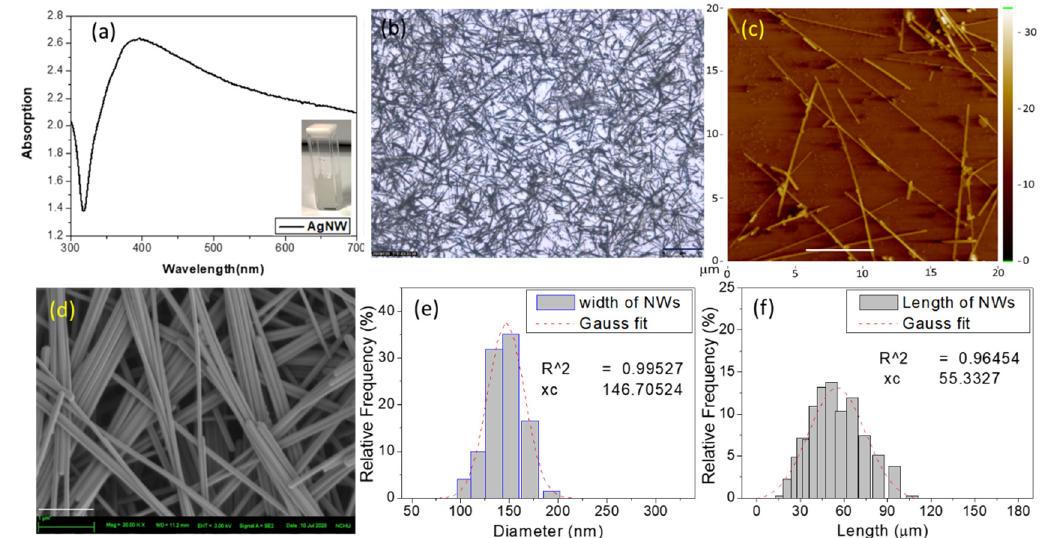
Figure 2. ( a ) Absorption spectra for Ag nanowires (NWs) (5 mg/mL); the insert shows the real-color aqueous solution photograph. ( b ) Microscopy, scale bar is 25 µ m; ( c ) AFM, scale bar is 5 µ m; ( d ) SEM image of Ag NWs, scale bar is 1 µ m. ( e ) Width and ( f ) length data from dynamic light scattering (DLS).